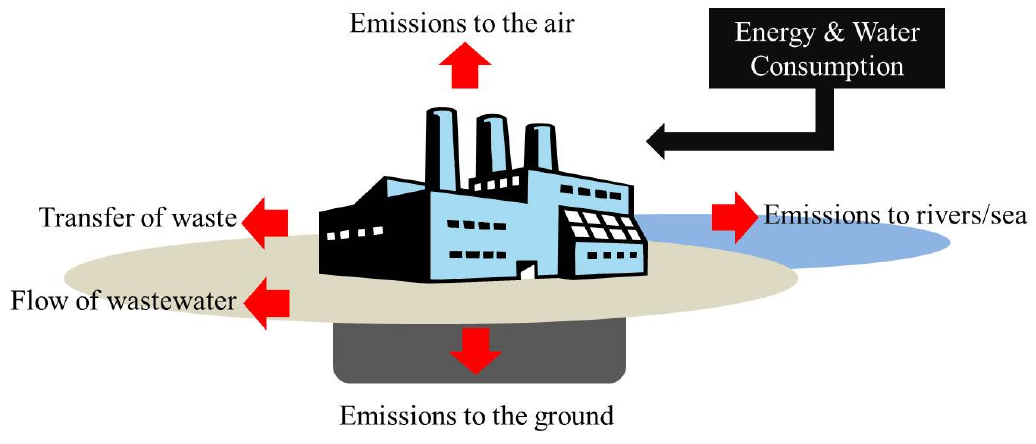
Figure 5. Emission and transfer information of chemicals PRTR provides (modified from [23]).